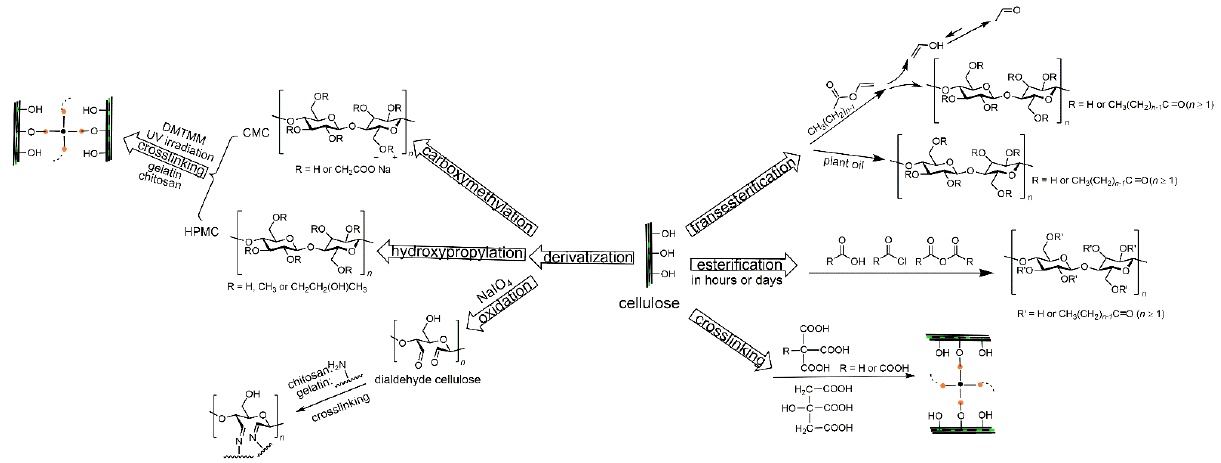
Figure 2. (Trans)esterification and crosslinking reaction schemes of cellulose and cellulose derivatives. 2. Cellulose Sources, Extraction Methods, and Size, Crystallinity and Functionality of